Question: Condense the content of this figure into a single sentence.
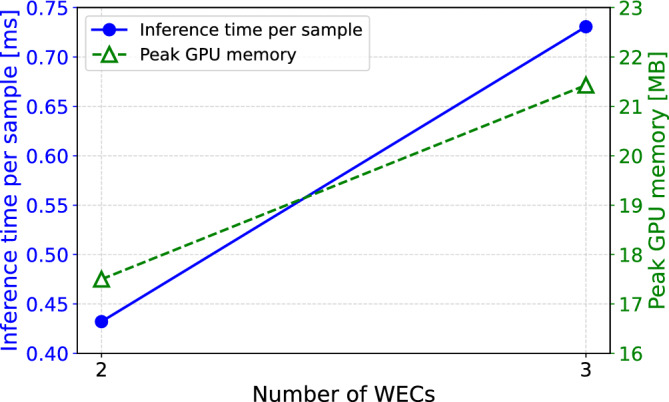
Answer: Inference time per sample and peak GPU memory usage as a function of the number of WECs. One sample corresponds to a single prediction time step, where the model predicts the angular displacement of all WECs in the array. Measurements are obtained using an NVIDIA Tesla T4 GPU.